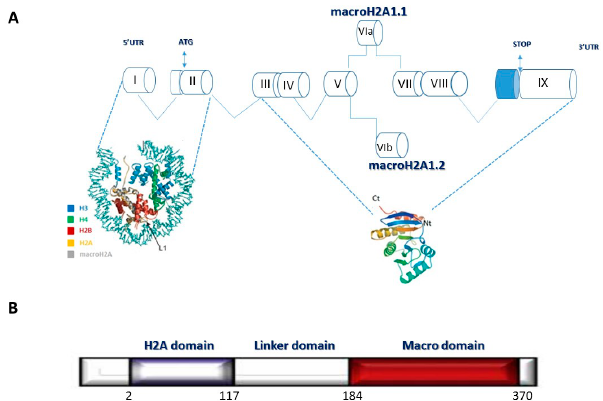
Figure 1. ( A ) Diagram illustrating macroH2A1 gene structure and transcript alternative splicing; ( B ) organization of domains in the protein structure. ( B ) organization of domains in the protein